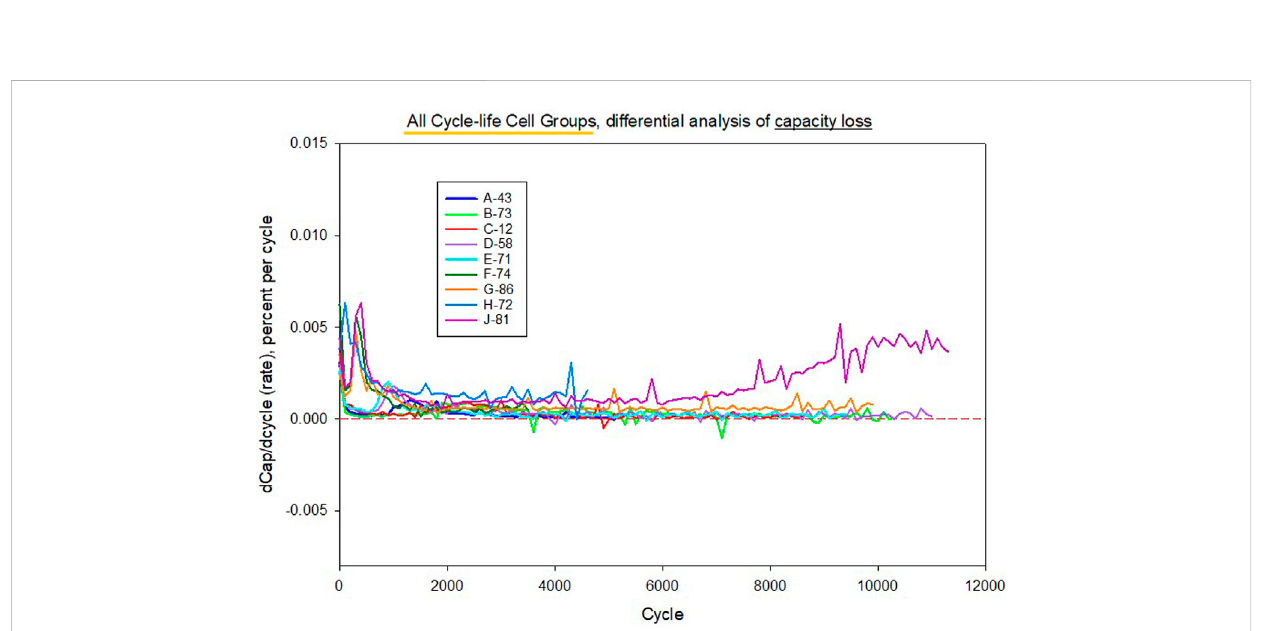
DifferentialrateanalysisofC/1capacitylossforrepresentativeLMO/LTOcellstestedunderninedifferentcycle-lifeconditions.Datavariancepercell is relatively low. Mechanistic trends are visible, such as gas formation in cell J-81 evidenced by an increasing rate after the fi rst 6,000